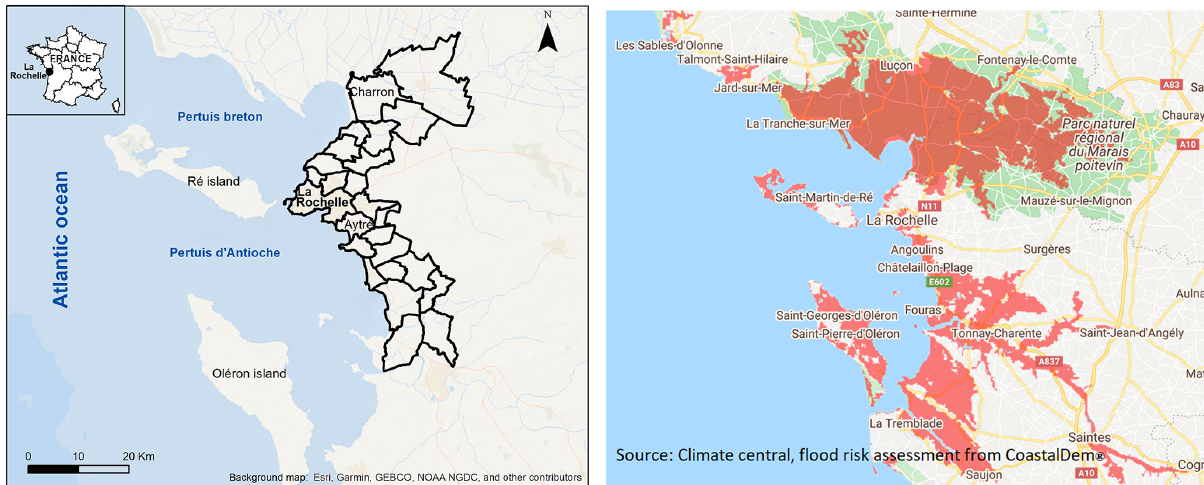
Figure 1. Left panel: the 25 coastal municipalities studied close to the city center of La Rochelle on the Atlantic coast (the black lines represent the municipal boundaries; Aytré and Charron are the main studied municipalities; source: IGN BDTopo ® ). Right panel: flood risk assessment (in red: the land projected to be below annual flood level in 2050; the coastalDEM ® does not take into account dikes or other hard defense